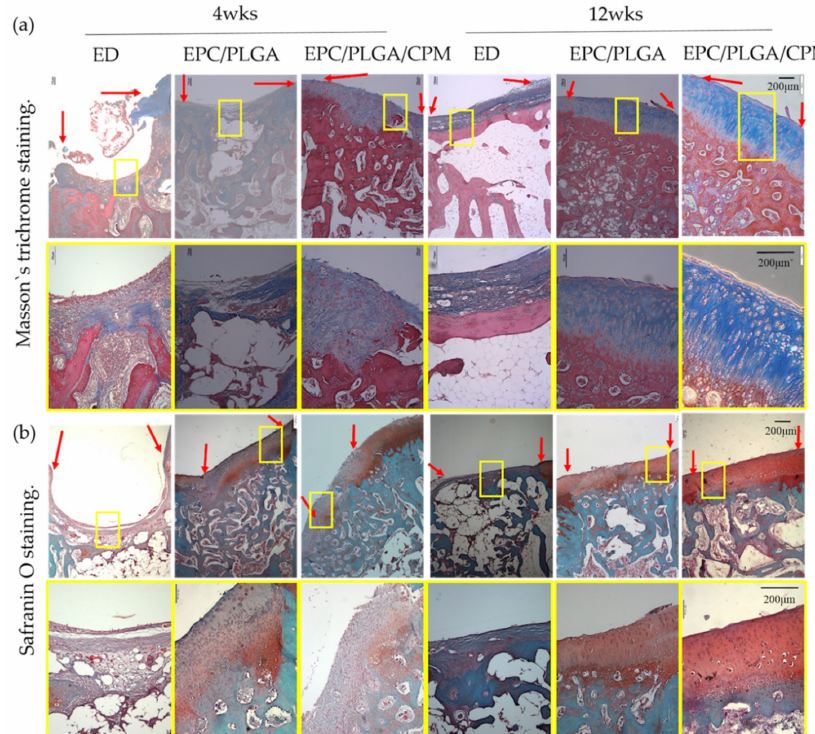
Figure 5. Histology of the different groups. Representative images of histological examinations using ( a ) Masson’s trichrome and ( b ) Safranin O staining. At week 4, the EPC/PLGA/CPM group showed distinctly smooth and thick cartilage and subchondral bone formation. In the EPC/PLGA group, fibrocartilaginous tissue was mixed with a mild cartilaginous matrix. At week 12, the EPC/PLGA/CPM group showed regenerative tissue in the defect sites that was almost exclusively hyaline-like cartilage with a regular surface and was well-integrated with the preexisting tissue. In the EPC/PLGA group, more abundant cartilage formation and bone regeneration than at 4 weeks were apparent, but the osteochondral junction between the regenerated tissue with the host tissue was apparent. In the ED group, we observed fibrous tissue formation and discontinuous subchondral bone reconstruction. A yellow square denotes the magnification scale. A red arrow shows the border of the repaired tissue. Scale bar 200 µ